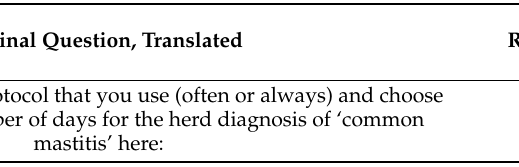
Table A3. Distribution of respondents treatment choice and duration in days for systemic antibiotics, local antibiotics and nonsteroidal anti-inflammatory drugs (NSAIDs) used often or always by Danish veterinarians (n = 70) for a herd diagnosis of “common